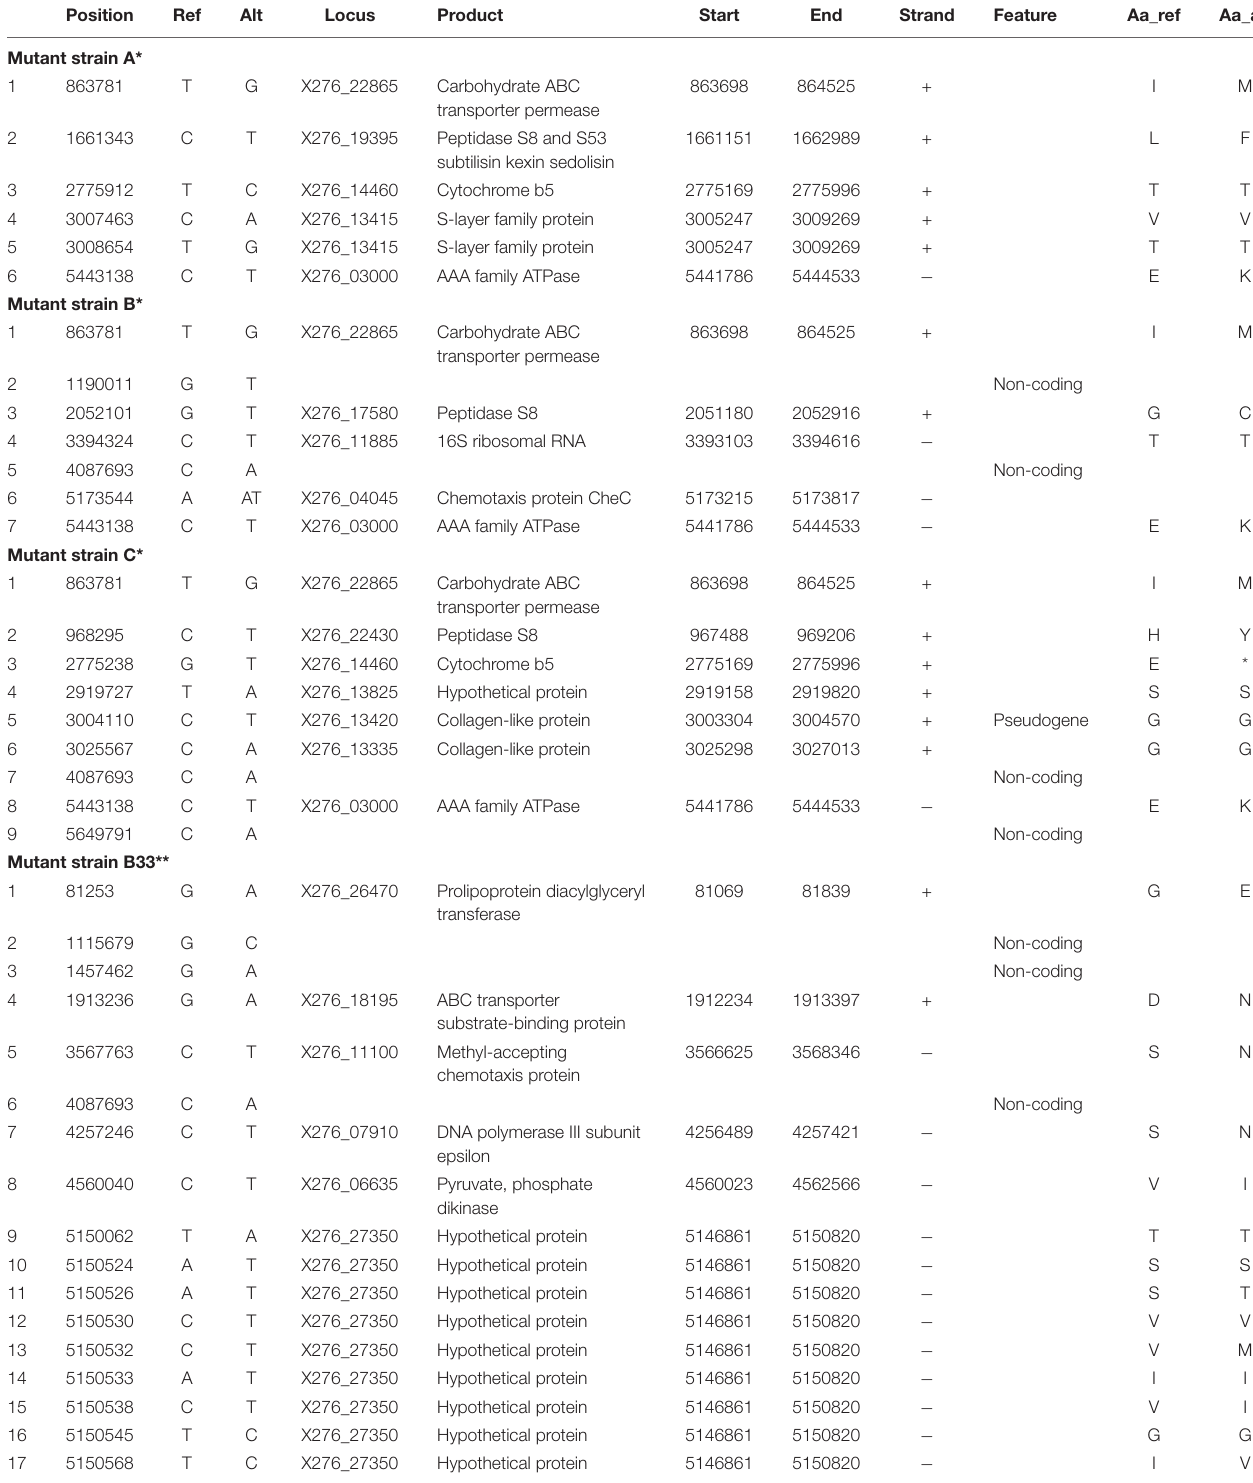
TABLE 3 | List of single-nucleotide polymorphisms that occurred in mutant strains of C. beijerinckii NRRL B-598 exhibiting high butanol tolerance 1 . Position Ref Alt Locus Product Start End Strand Feature Aa_ref Aa_alt Mutant strain